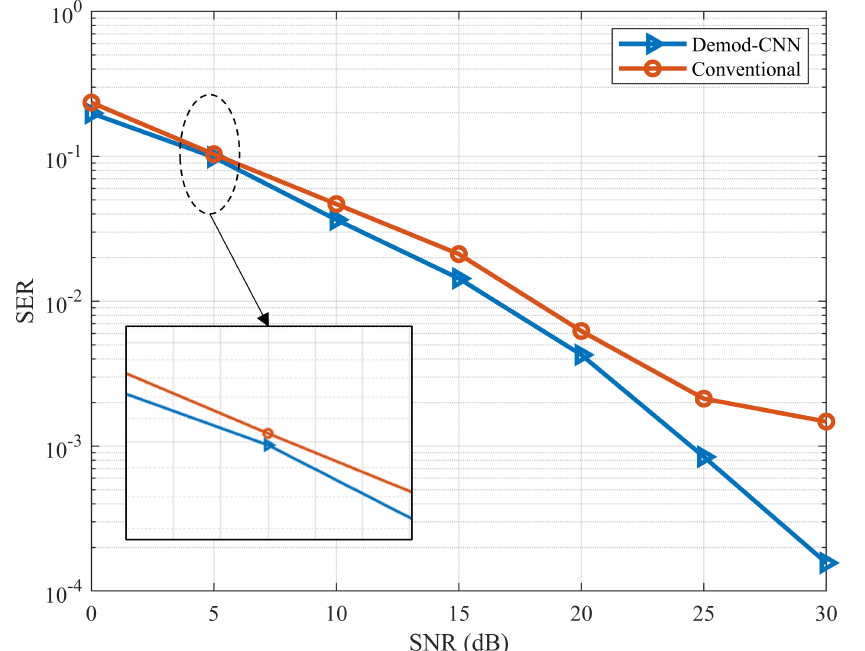
Figure 6. SER performance comparison of the proposed Demod-CNN and conventional